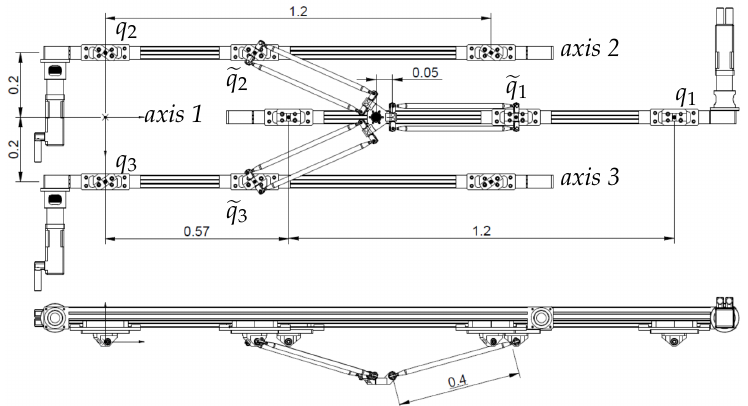
Figure 5. Diagram of the linear